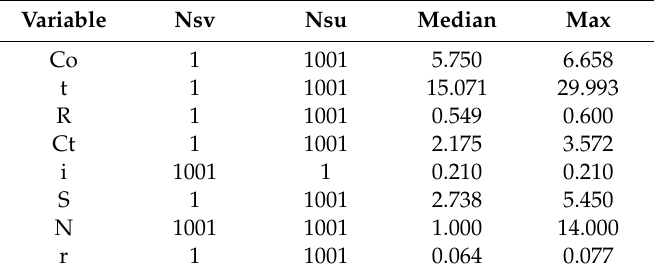
Table 7. Uncertainty and variability of variables.